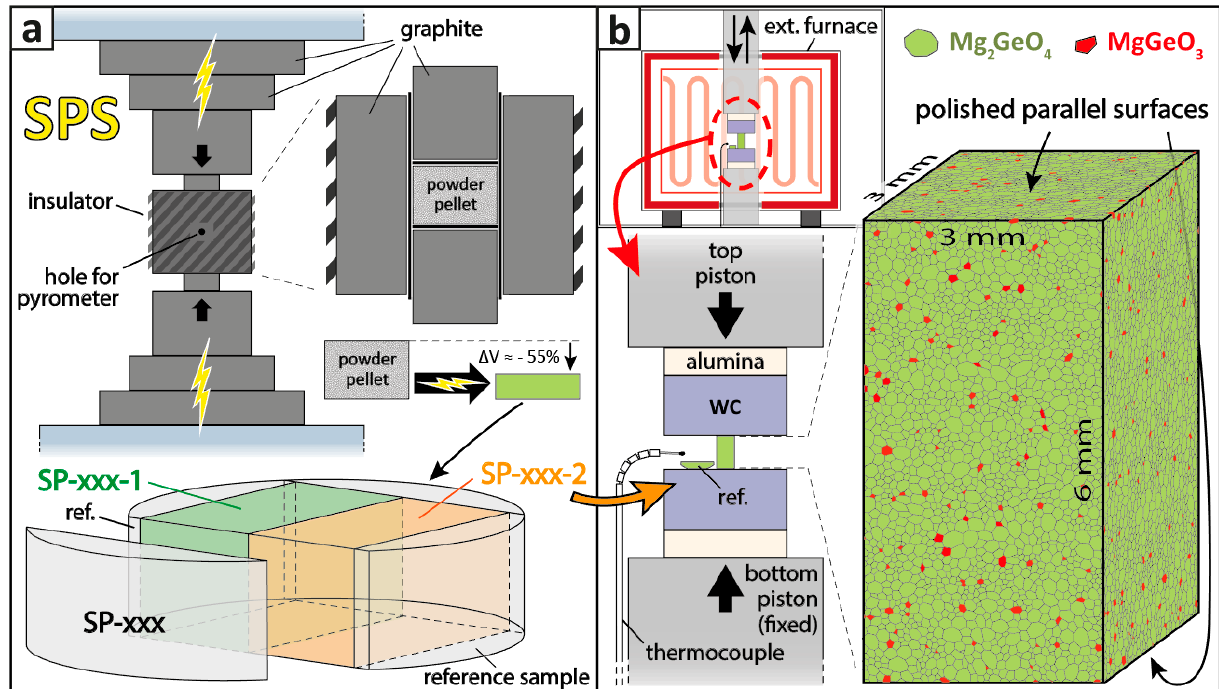
Figure 3. Experimental setup: synthesis and deformation experiment. ( a ) Spark plasma sintering (SPS) and preparation of deformation samples; ( b ) Design of deformation experiments (top left subfigure inspired from [30]) and schematics of a sample before deformation. WC = tungsten carbide.